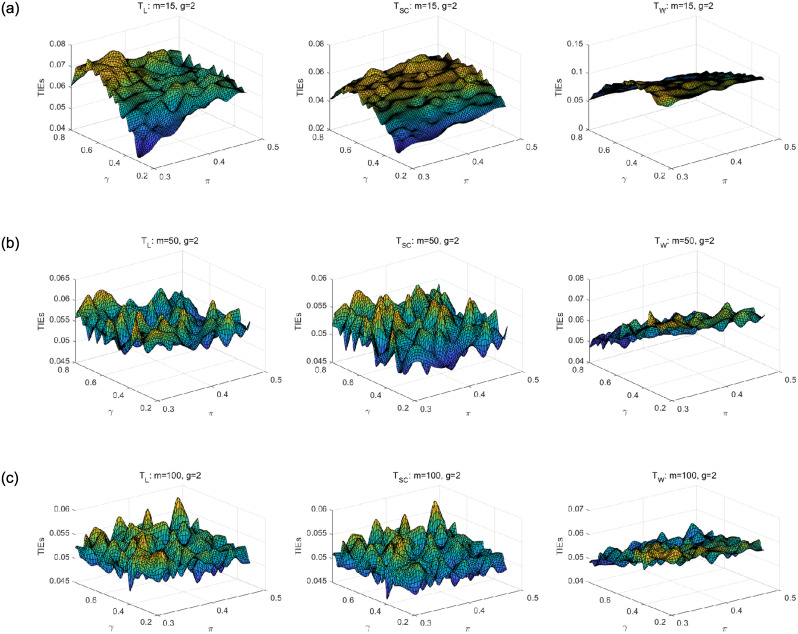
Empirical TIE surfaces of asymptotic tests for g = 2, πi = π and γi = γ.